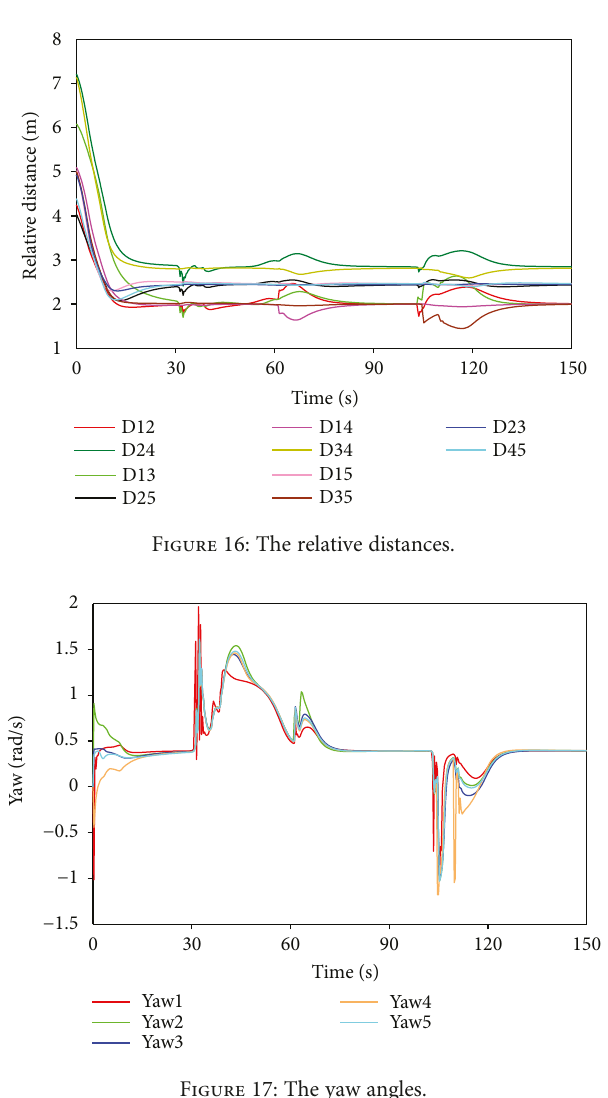
Figure 17: The yaw